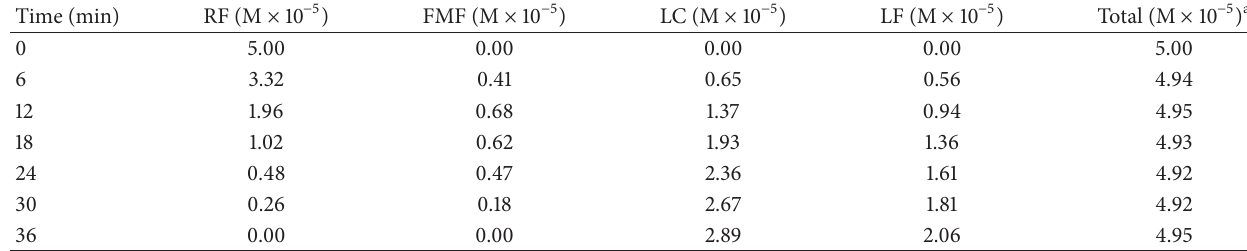
Table 2: Concentrations of RF and photoproducts at pH